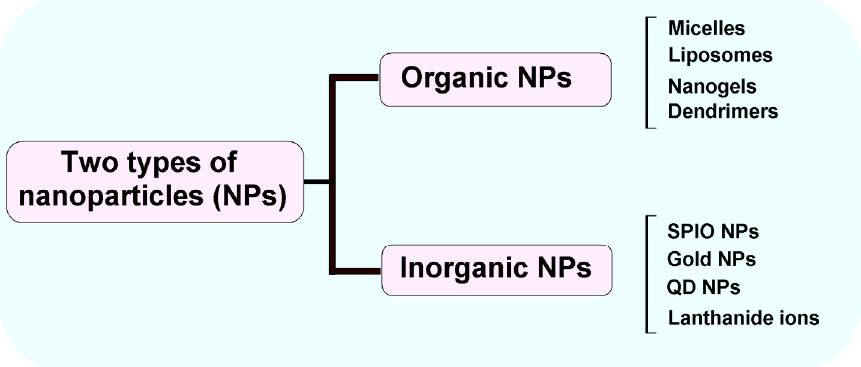
Figure 2. Inorganic and organic nanoparticle (NP) materials. Multifunctional NPs can be synthesized using two basic types of NPs; organic (micelles, liposomes, nanogels and dendrimers) and inorganic (superparamagnetic iron oxide (SPIO), gold, quantum dots (QD) and lanthanide